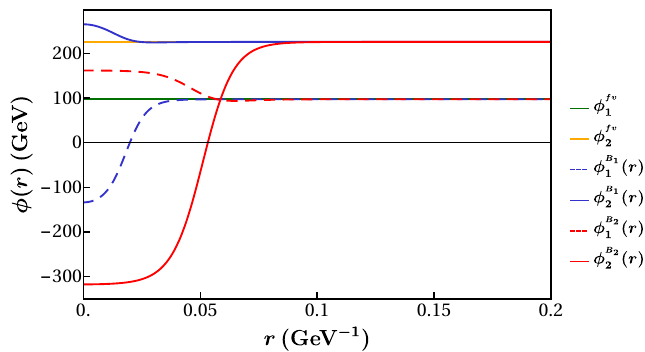
Figure 4 . Bounce solutions for (cid:12)elds (cid:30) 1 and (cid:30) 2 for the transitions from N to N 0 ( B 1) and from N to N 0 ( B 2). In both cases the (cid:12)elds (cid:30) i tend to the same values at r ! 1 , i.e. the values of the (cid:12)elds at the false vacuum N , (cid:30) fv e (cid:30) fv . But at r = 0 the (cid:12)elds assume di(cid:11)erent values, close to the 1 2 vevs at each of the degenerate true